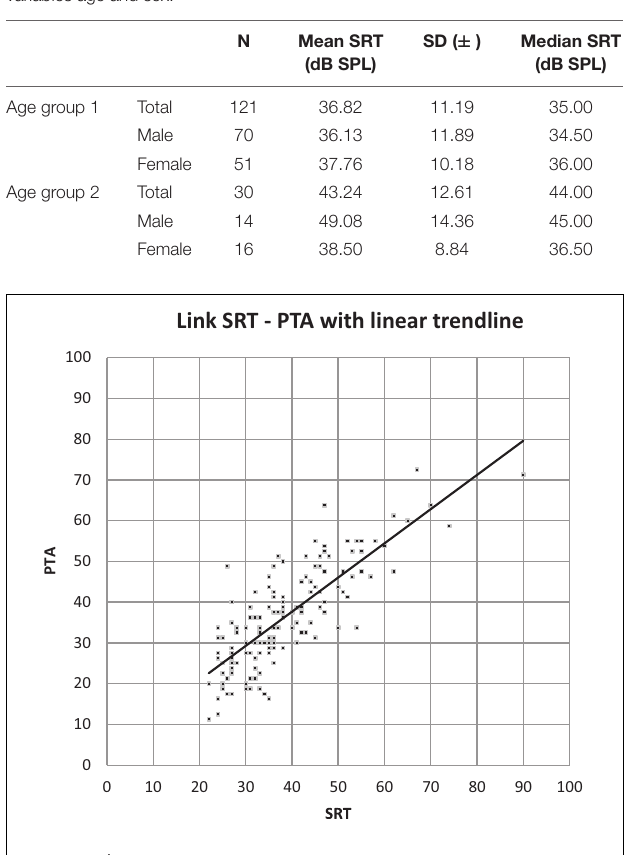
were slightly higher than those of PTA; however, when looking at the interclass correlation coefficient, we saw that the PTA and SRT of the better ear had a high correlation of